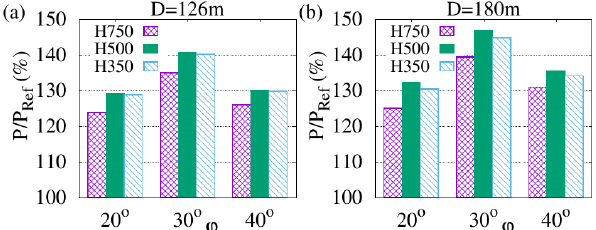
Figure 5. Dependence of power gains on tilt angles ϕ in the ABLs with H = 750, H = 500 and H = 350m. (a) D = 126m turbines. = (b) D = 180m turbines. Tilted-rotor turbines are operated at C (cid:48) T 3. = 3 wise directions respectively and the operation mode ( C (cid:48) T = 1 . 5 for the others). First, an array of for tilted rotors, C (cid:48) T turbines with D = 180 m and z h = 115 m (inspired by the DTU 10 MW model) is considered in the same 3 km × 3 km domains already used (three rows with four turbines each are accommodated in the domain). Then, arrays of even larger turbines with D = 250 m, z h = 150 m and D = 360 m, z h = 230 m are accommodated in 6 km × 3 km domains (three rows with three and two turbines respectively in each row).